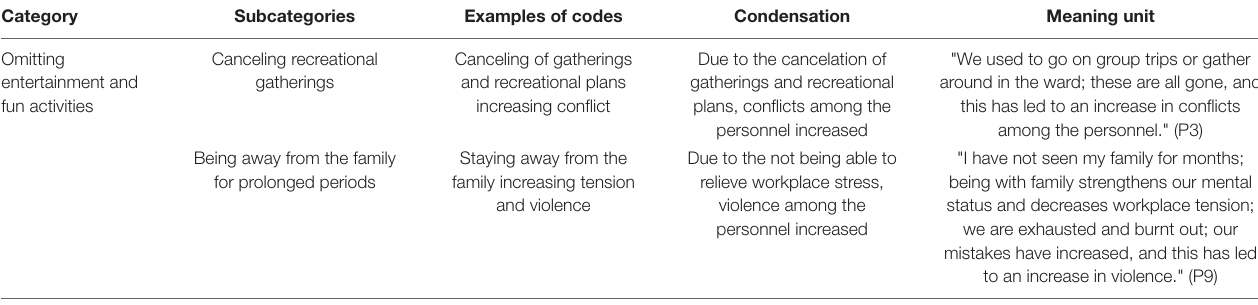
TABLE 2 | Example of qualitative content analysis process.